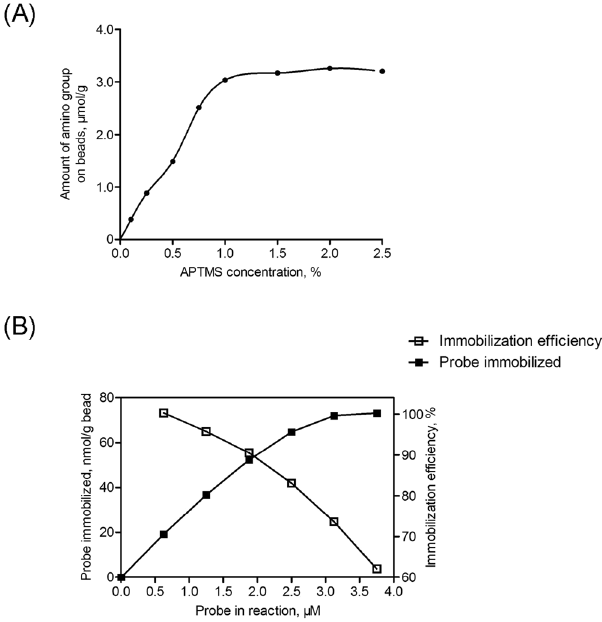
Figure 6. ( A ) APTMS concentration effect on the availability of amino groups. In the analysis of Fmoc, the mobile phase of HPLC was consisted of solvent A (0.025 M potassium dihydrogen phosphate) and solvent B (methanol). Isocratic elution with the mobile phase ratio of A:B (25:75) was employed. ( B ) Relationship between the amounts of total DNA-peptide probe input and immobilized DNA-peptide probe ( ■ ). Immobilization efficiency ( □ ) was also determined,